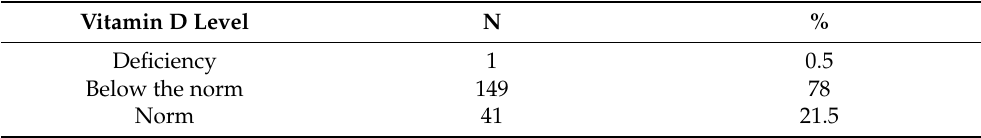
Table 3. Marked level of vitamin D in the serum of studied women (N =